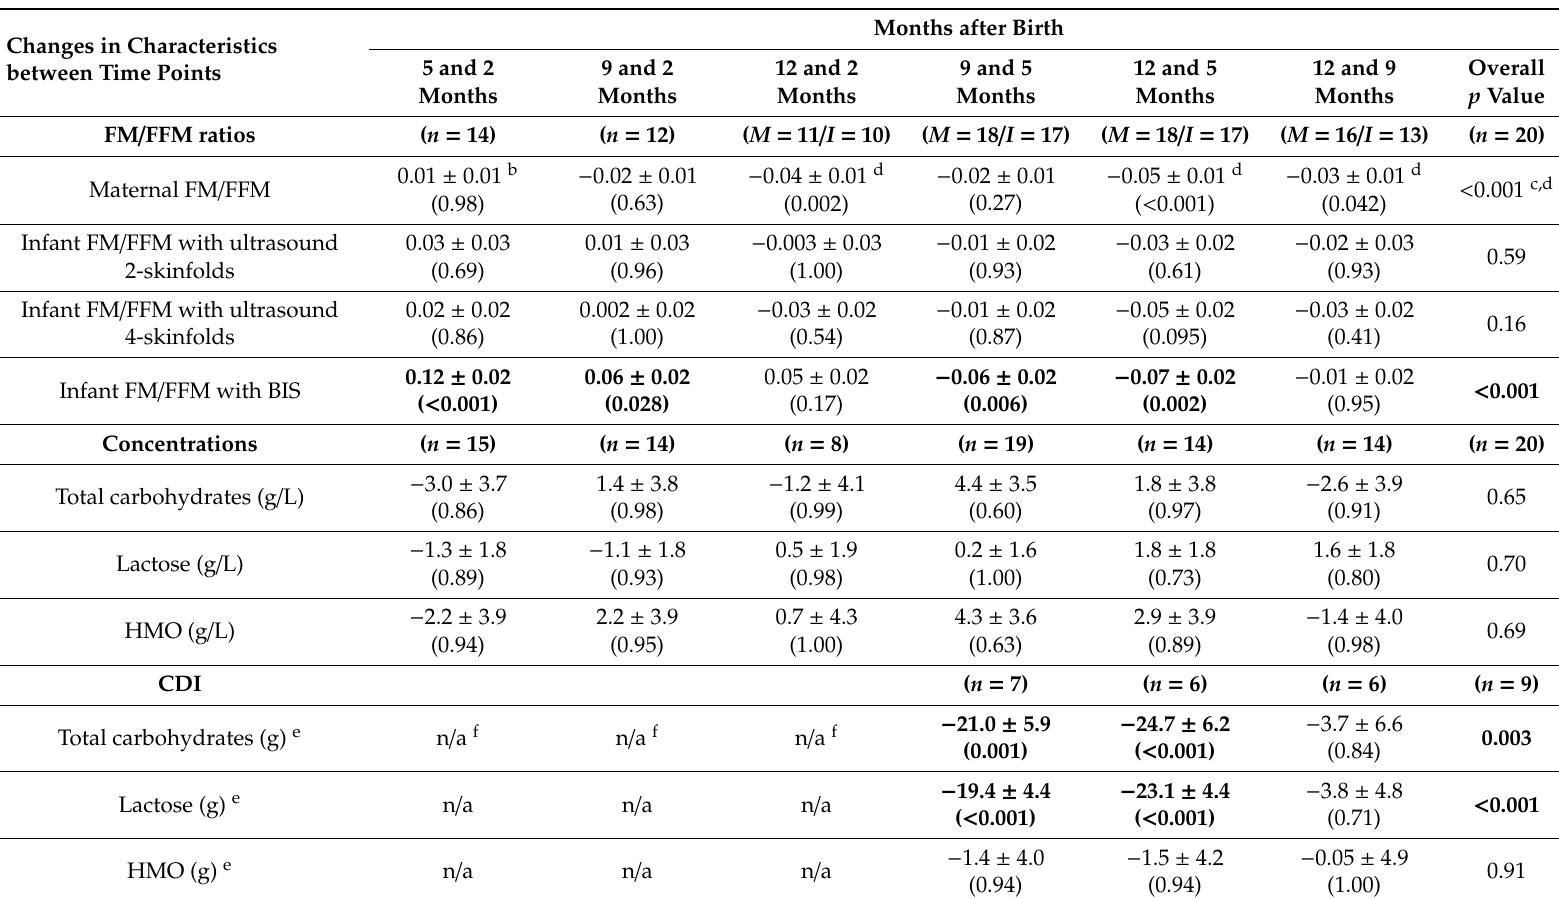
Table 2. Di ff erences by infant age / lactation duration within fat mass to fat-free mass ratios and measured human milk carbohydrates a . Changes in